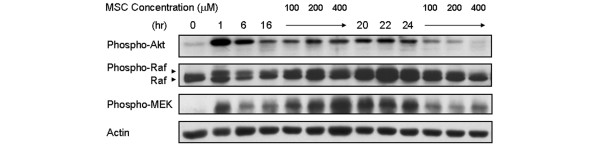
Effect of Se-methylselenocysteine (MSC) on phospho-Akt, phospho-Raf and phospho-MEK in TM6 cells. The TM6 cells were synchronized in minimal medium as described in Fig. 1, but only for 24 hours. Then the MSC (100 to 400 μM) was added (in minimal medium) for 16 and 24 hours. The cells were stimulated with fresh DMEM/F12 containing growth factors (5 ng/ml epidermal growth factor and 10 μg/ml insulin) and serum (2% adult bovine serum) at the indicated time points for 1 hour. Equal amounts of lysates (20 μg of protein) were loaded on each lane for each time point. Immunoblots were probed with anti-phospho-Akt, anti-phospho-Raf, anti-phospho-MEK and anti-actin antibodies as described in the Materials and methods section. Both the Akt and Raf were phosphorylated within 1 hour of stimulation with growth factor and serum. At 16 hours a dose of 400 μM MSC failed to inhibit the phosphorylation of Akt or Raf and the downstream effector MEK. However, at 24 hours MSC was able to inhibit phosphorylation of all three proteins in a dose-dependent manner.